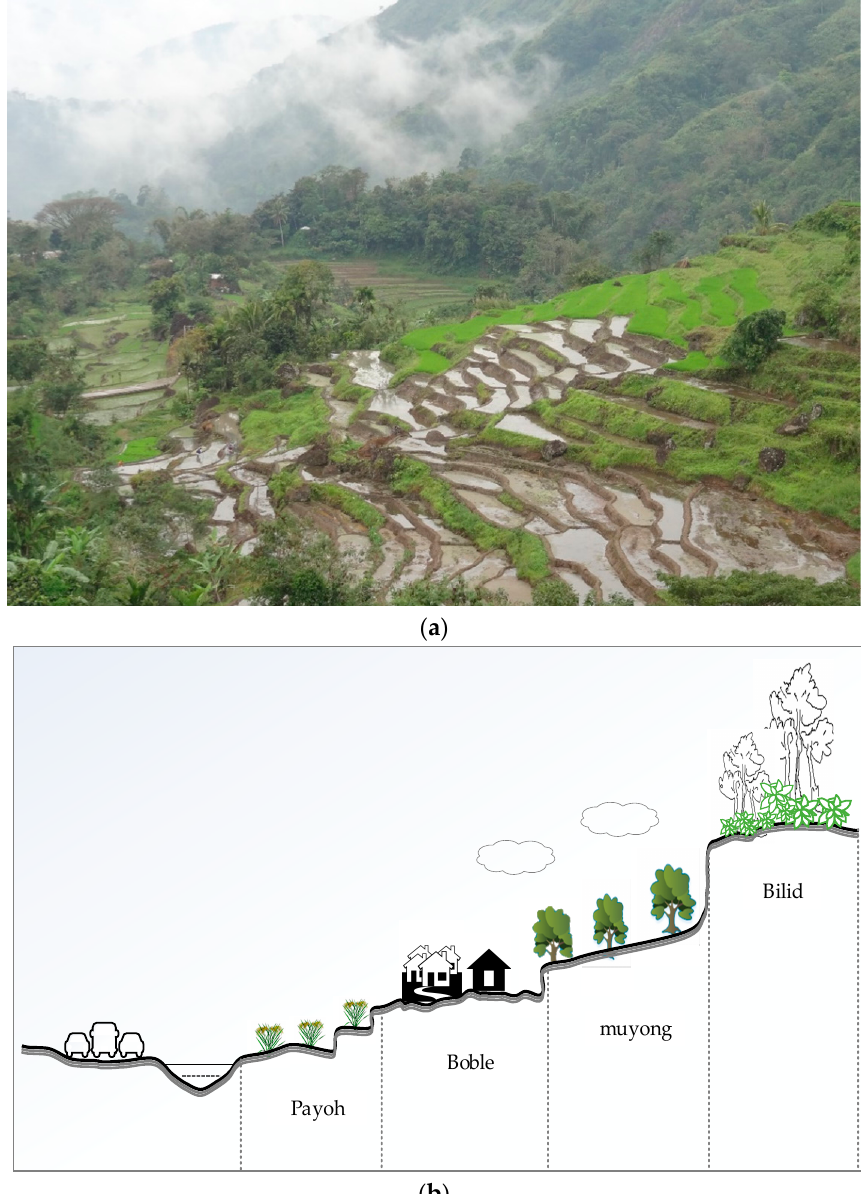
Figure 4. ( a ) Mountain landscape of Ifugao rice terraces. ( b ) Transect shows various land management systems with elevation in Ifugao.